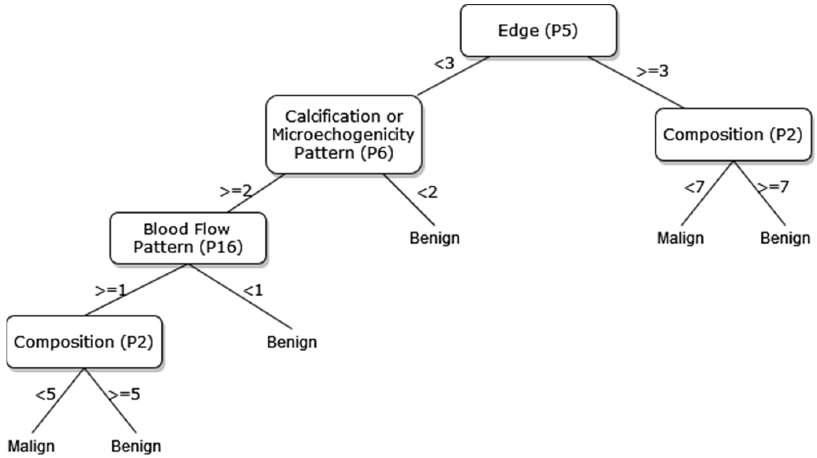
Figure 9. The pruned DT of 13 sonographic signs.